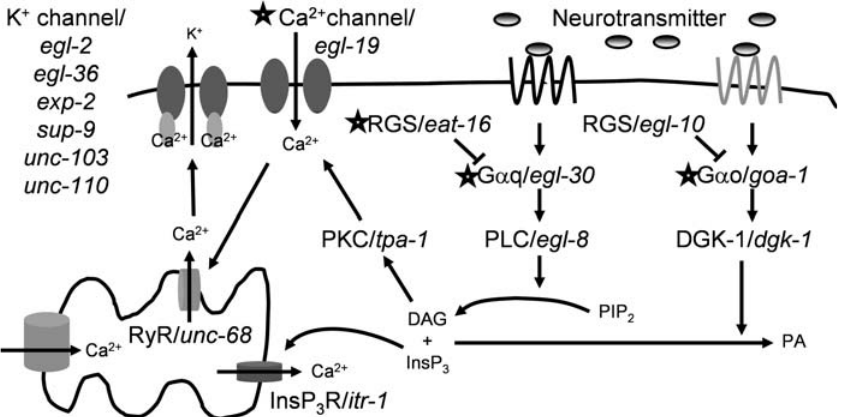
Figure 5. Analysis of Molecular Signaling Events Controlling Muscular Contraction in C. elegans The diagram shows the molecular components of the signaling pathways downstream of the muscarinic GPCRs in C. elegans . Alleles of genes encoding proteins in the pathway were tested for their effect on the Egl-d phenotype caused by treatment with BMS-192364. For the pathway members indicated by stars, certain alleles altered the response to treatment with BMS-192364. Specifically, resistance to the Egl-d phenotype was conferred by two gain-of-function alleles of egl-19 and one of egl-30, and by two loss-of-function alleles of eat-16 and one of goa-1 . DOI: